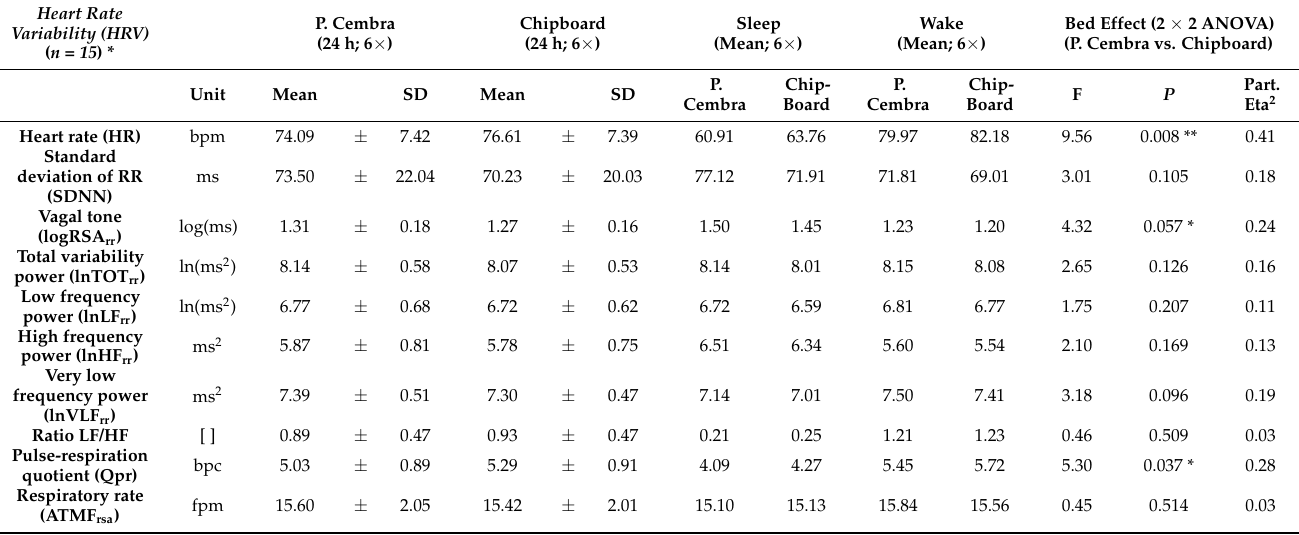
Table 1. Heart rate, cardiorespiratory interaction (CRIs) and autonomic measures—24 h, awake and asleep in different types of